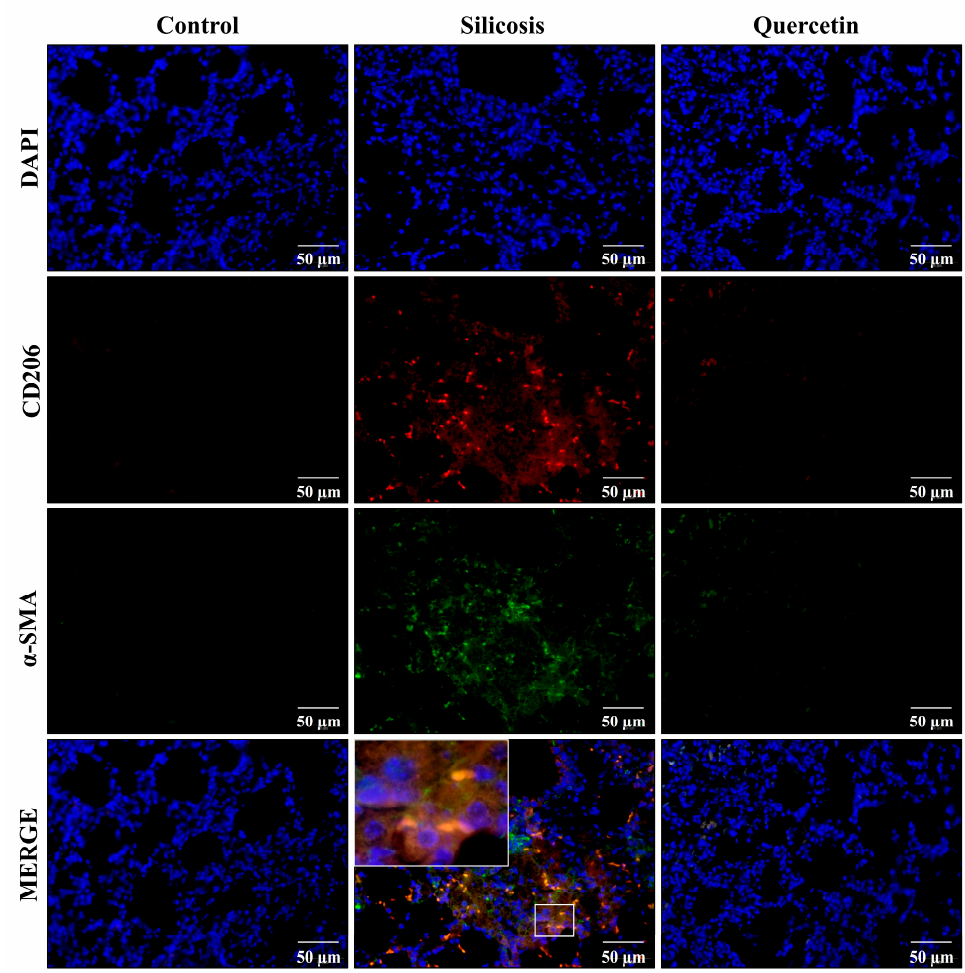
Figure 7. The expressions of CD206 and α -SMA in the lungs, measured by immuno fl uorescent staining (scale bar = 50 µm). Blue, DAPI; red, CD206; green, α -SMA.